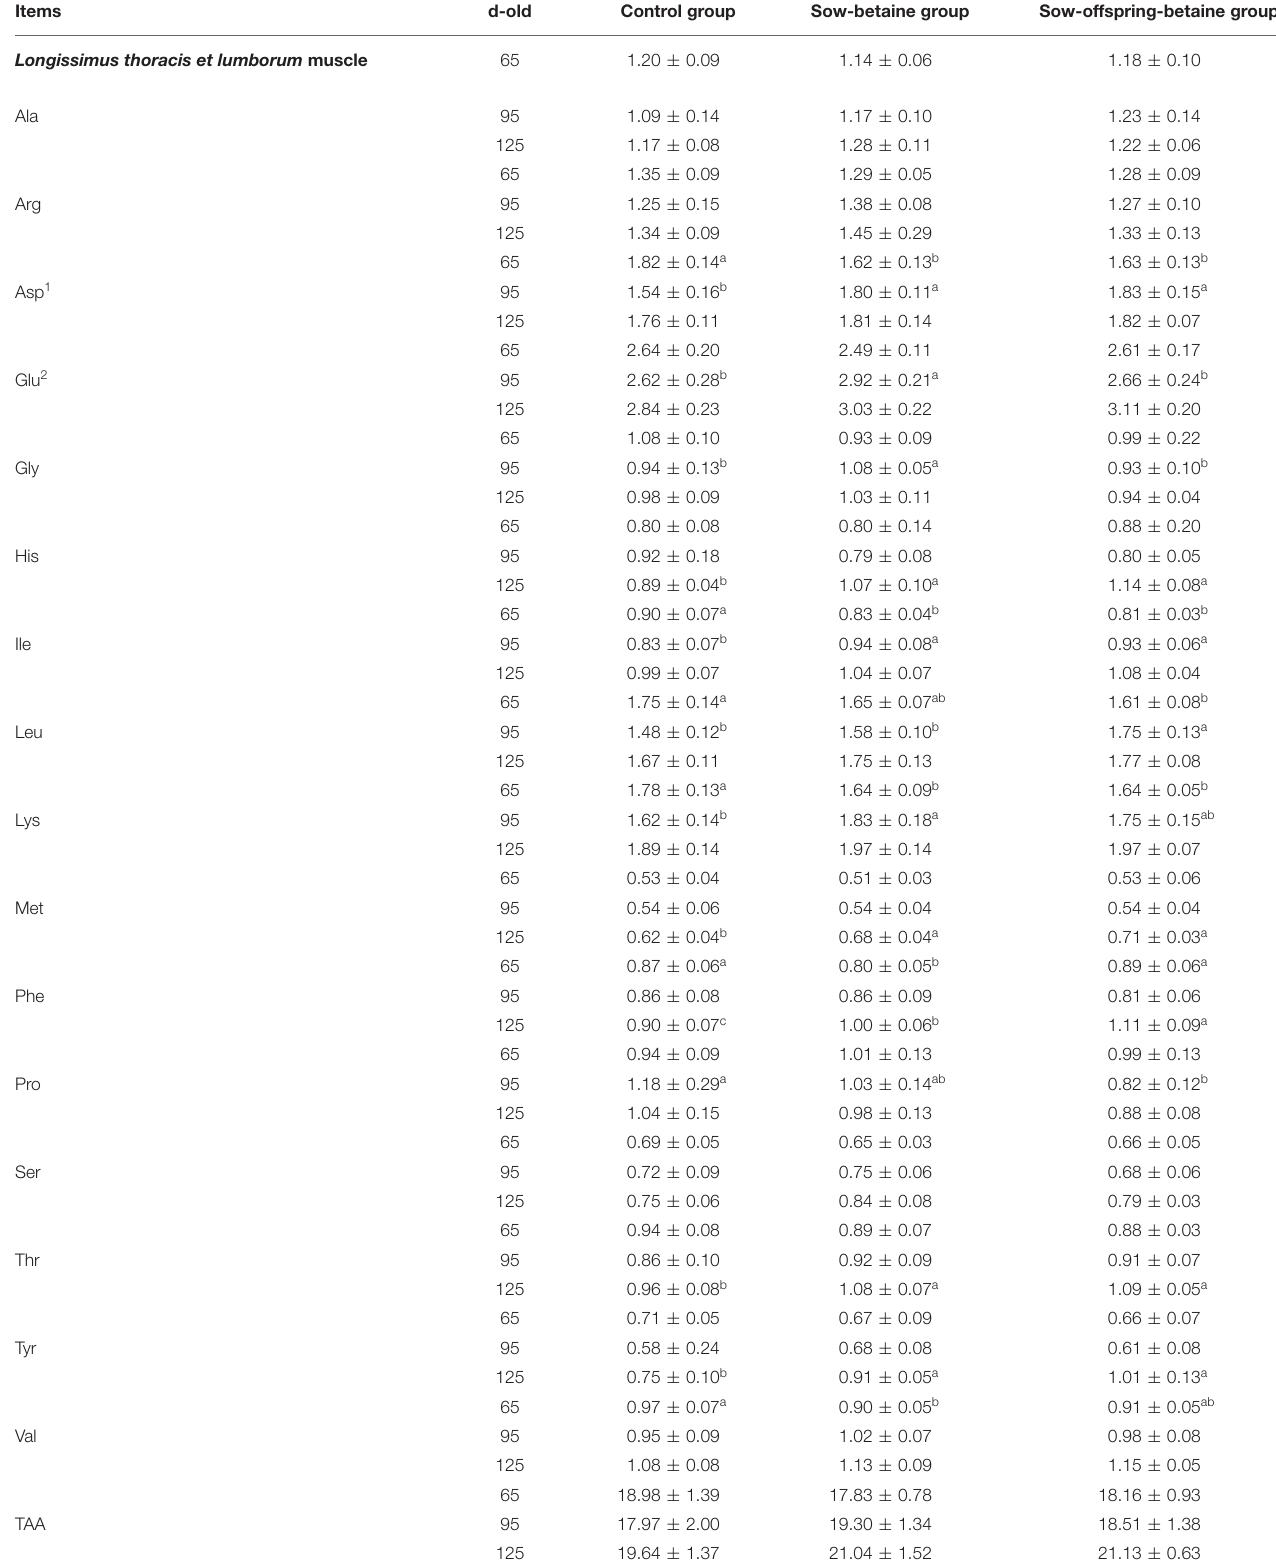
TABLE 6 | Effect of dietary betaine on hydrolyzed amino acid content in muscle of Bama mini-pigs (fresh weight basis; %). Items d-old Control group Sow-betaine group Sow-offspring-betaine group Longissimus thoracis et lumborum